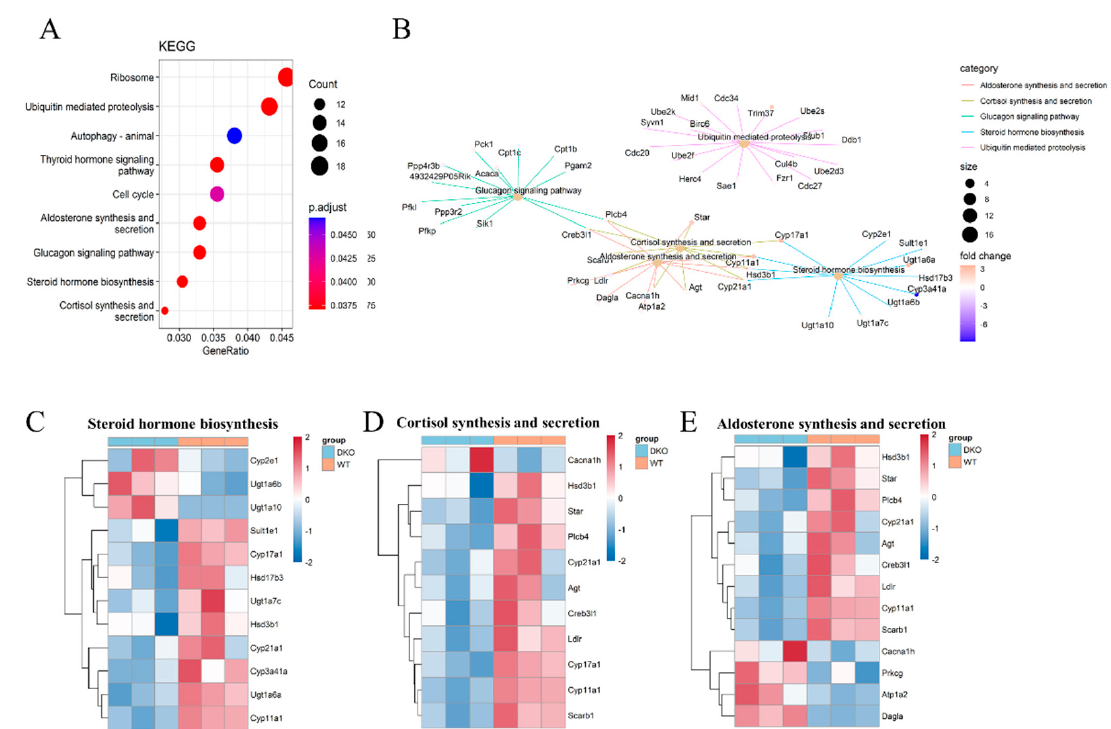
Figure 3. KEGG analysis of DEmRNA in 15-month-age DKO mice. ( A ) KEGG pathway analysis of mRNAs. ( B ) The net plot of KEGG pathways shows the enrichment of DEmRNAs in different pathways. Color dots represent the fold change of gene expression in different pathways. The y-axis represents the gene count. The x-axis gives the enrichment analysis terms. Plot colors represent the p -values and sizes represent the gene numbers. ( C )–( E ) Heatmap for DEmRNAs enriched in steroid hormone biosynthesis, cortisol synthesis and secretion, as well as aldosterone synthesis and secretion. Blue: DKO mice; Red: WT mice.